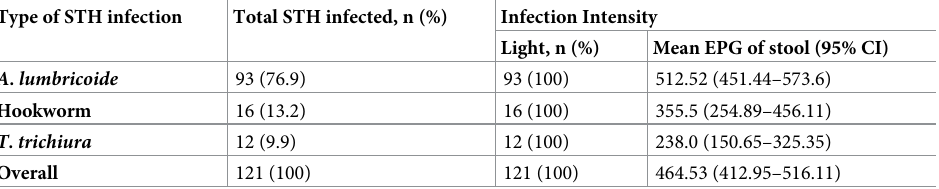
Table 3. Intensity of STHs infection among school children of Tachgayint woreda, Northcentral Ethiopia,